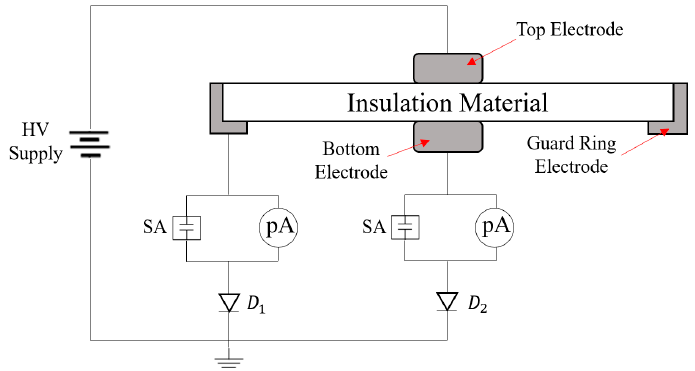
Figure 9. Circuit diagram of the guard-ring terminal electrode structure for measuring the insulator Figure 9. Circuitdiagramoftheguard-ringterminalelectrodestructureformeasuringtheinsulatorresistivity. resistivity.